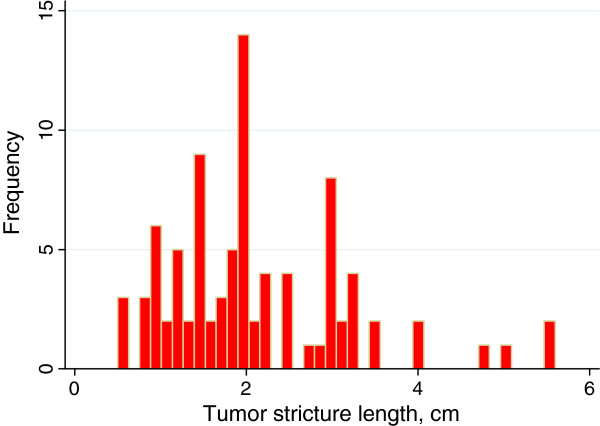
Distribution of bile duct stricture length in 88 patients.